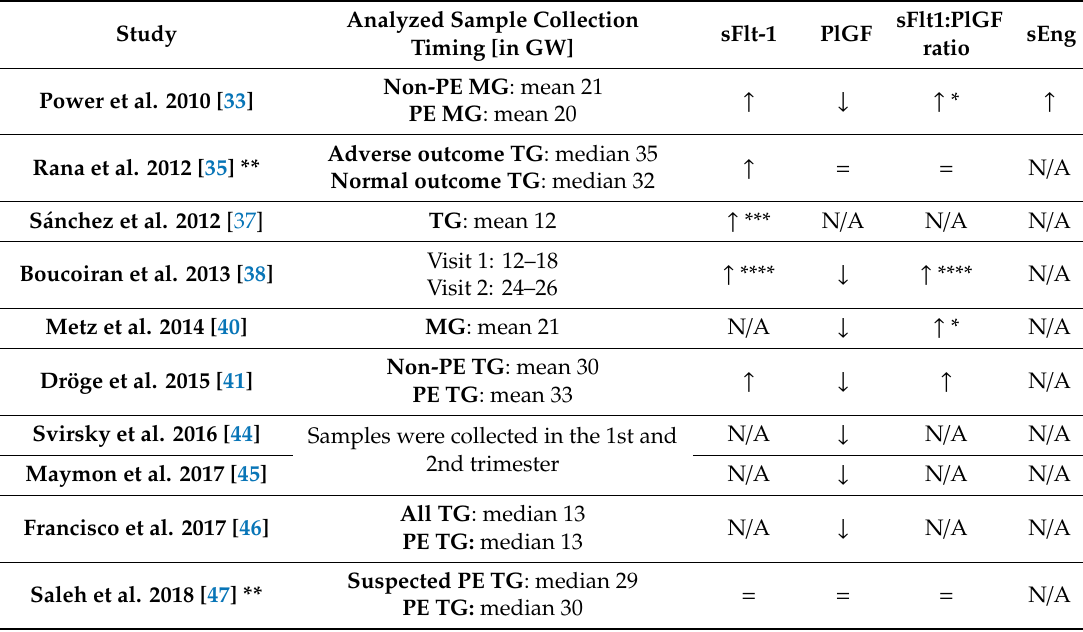
Table 3. Serum concentrations of sFlt-1, PlGF, sFlt1:PlGF ratio, and sEng in women in twin pregnancies who developed PE compared to women in twin pregnancies who did not develop